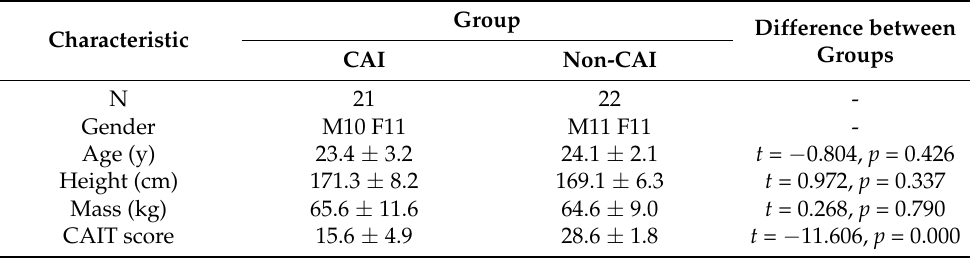
Table 1. Participant demographic information (Mean ± SD). Group Difference between Characteristic GroupsCAI Non-CAI N 21